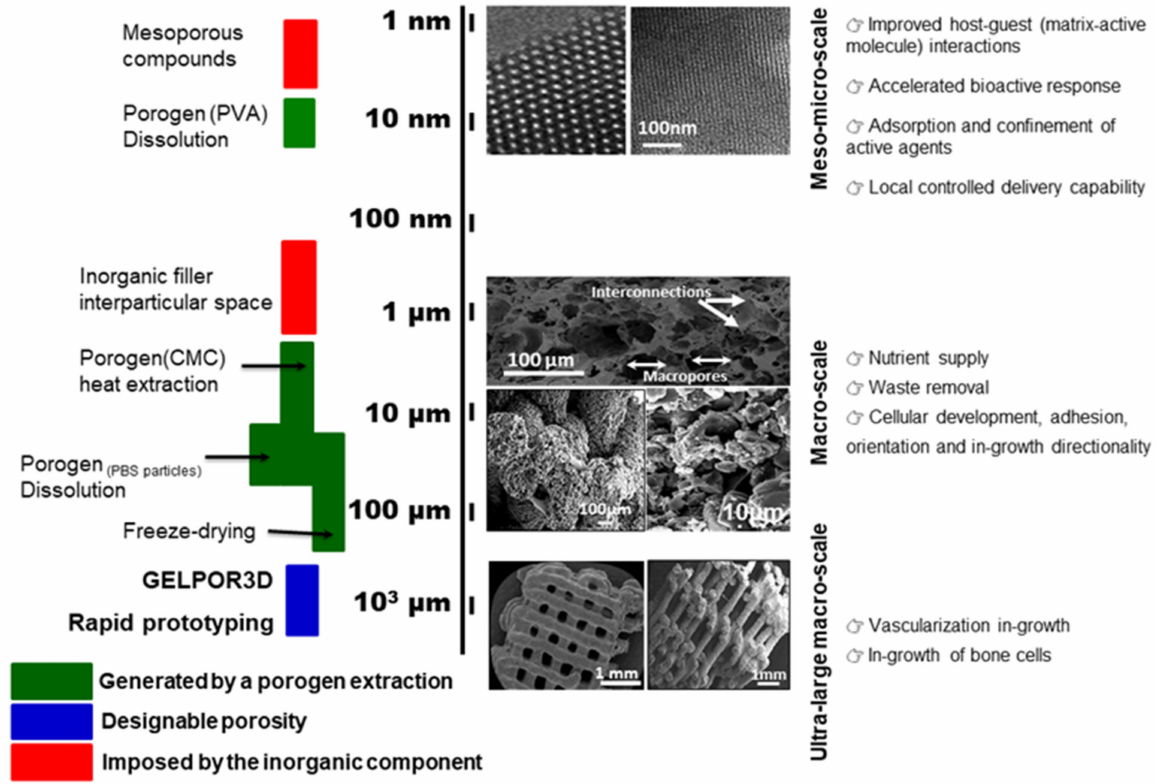
Figure 2. Schematic representation, related to the length scale, of the scaffolds pore distribution, the methods employed to obtain it, micrographs at different magnifications and the different physiological phenomena taking place (SEM micrographs reproduced with permission from Shruti et al. [10], Acta Biomater.; published by Elsevier, 2013 and Heras et al. [47], Acta Biomater.; published by Elsevier, 2019).